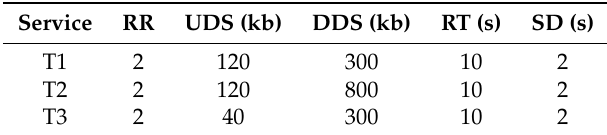
Table 1. Detailed information of the mobile services. The RR , UDS , DDS , RT , and SD columns show the Requested Resources, Upload Data Size, Download Data Size, the service Response Time, and the Service Downtime generated by service migration,